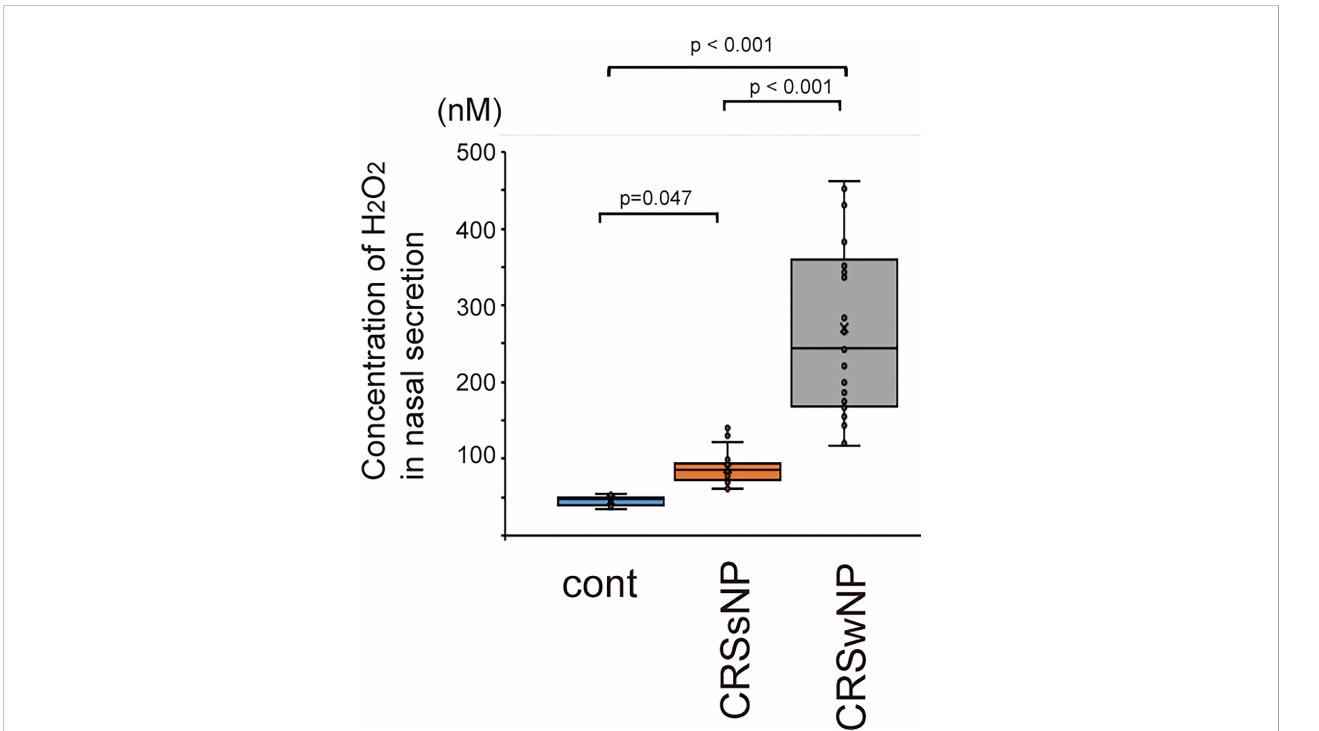
FIGURE 1 The concentration of H 2 O 2 in nasal secretion of normal control (n=15) and patients with CRSsNP (n=23) and CRSwNP (n=26). CRSsNP indicates chronic rhinosinusitis without nasal polyps. CRswNP means chronic rhinosinusitis with nasal polyps. Data are mean ±